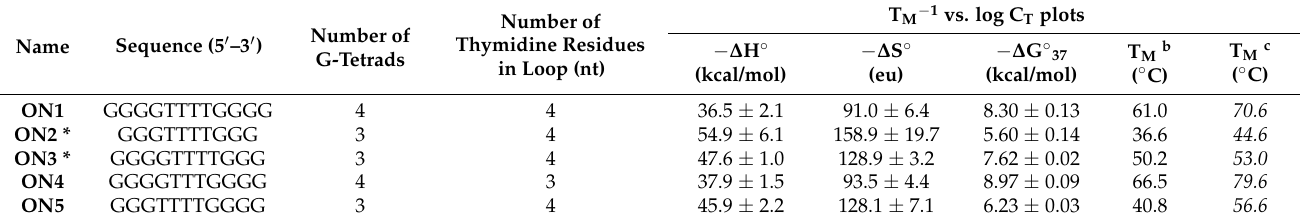
Table 1. Thermodynamic parameters of G-quadruplex formation